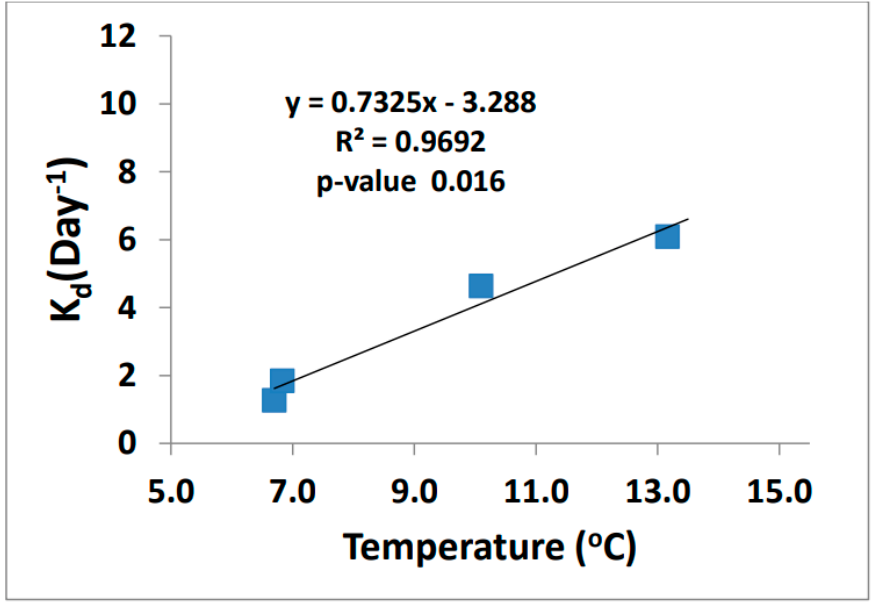
Figure 9. MeHg demethylation rate vs. ambient temperature ( n = 4).